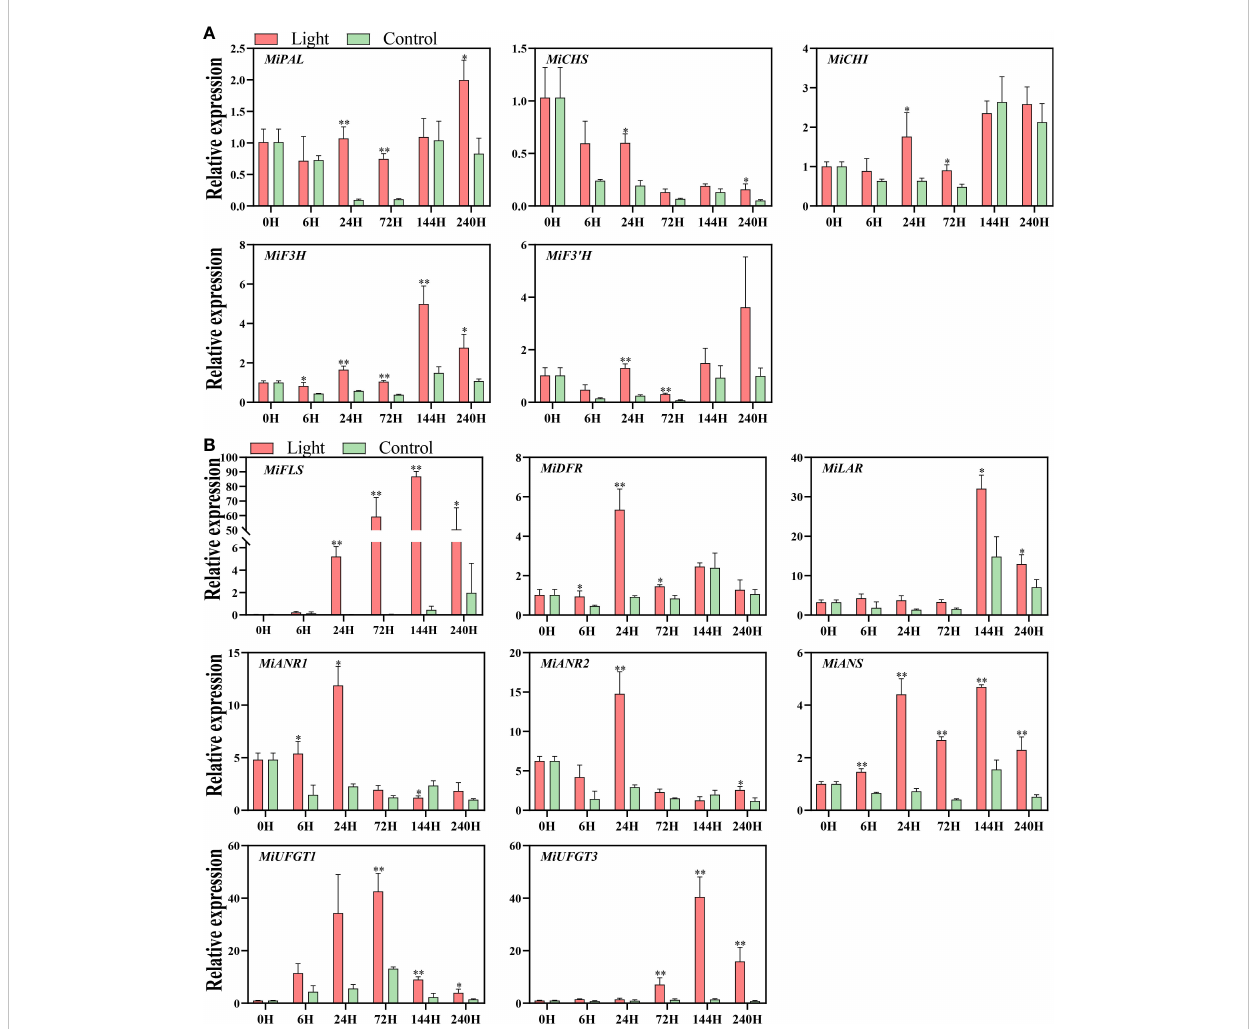
FIGURE 3 Effect of light treatment on the expression of early fl avonoids biosynthetic genes (A) and late fl avonoids biosynthetic genes (B) in ‘ Zill ’ mango peel. Each value represents the mean ± standard deviation of three biological replicates. * indicates signi fi cant difference ( p -value < 0.05), and ** indicates very signi fi cant difference ( p -value < 0.01) between control and treatment, as determined by Student ’ s t